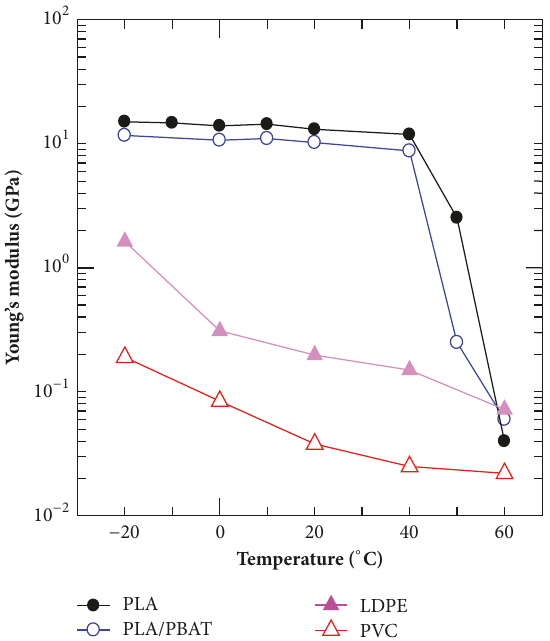
Figure 8: Young’s modulus of PLA and